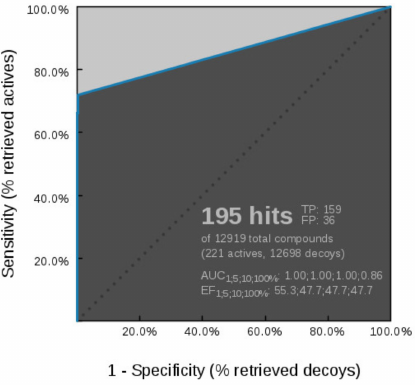
Figure 6. Receiver operating characteristic (ROC) curve resulting from parallel virtual screening of the GyrB active and decoy datasets with five GyrB inhibitor 3D-pharmacophore models. The parallel screening approach gives a high coverage of GyrB inhibitor active space while maintaining a low false-positive rate.